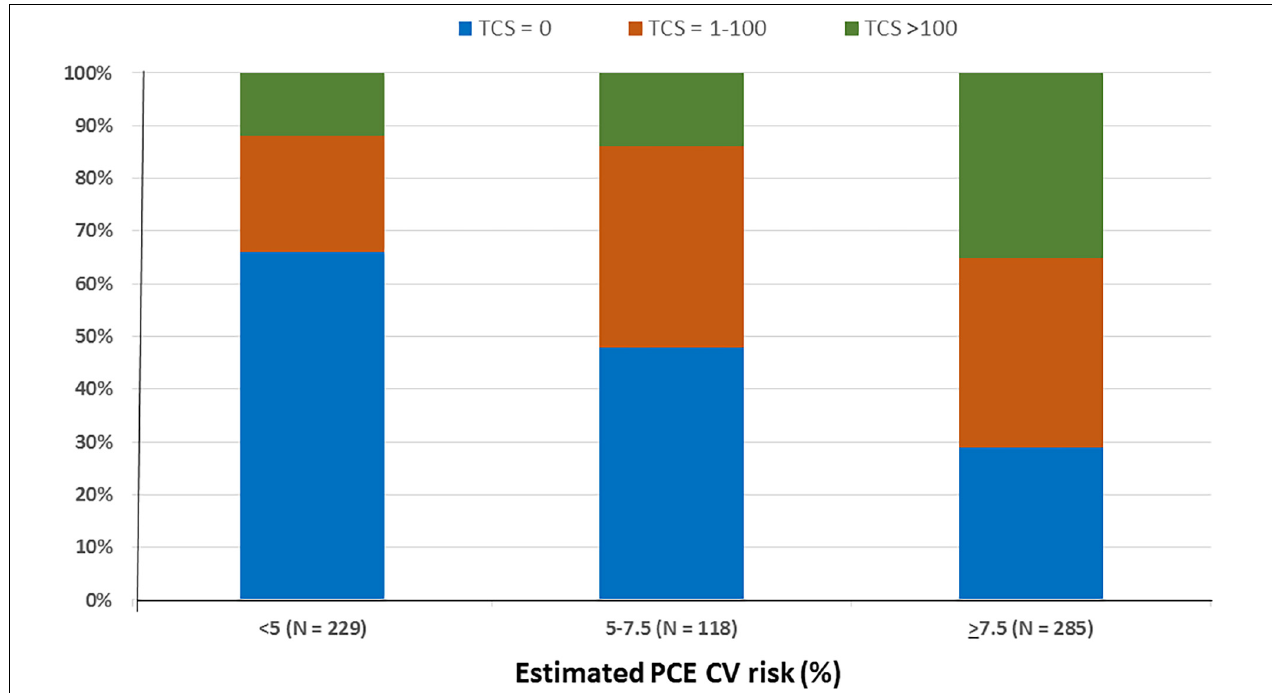
FIGURE 3 | Coronary artery calcification according to the estimated PCE CV risk. The subjects (632) were divided according to their PCE CV risk and total calcium score. Bars represent the estimated PCE CV risk category. Colors represent the total calcium score. N denotes the absolute number of subjects according to their PCE CV risk category. PCE, pooled cohort equations; CV, cardiovascular; TCS, total calcium